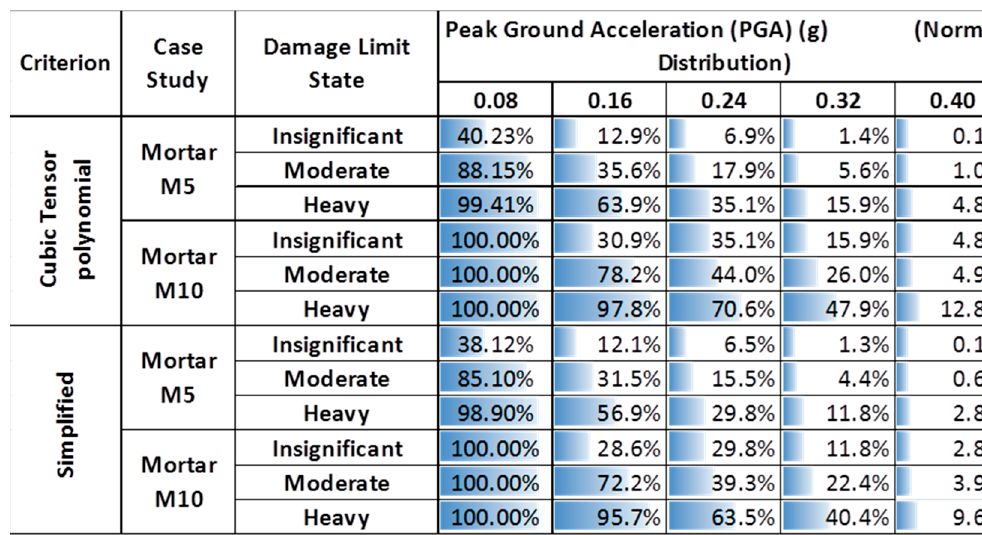
Figure 14. Fragility curves of the existing structure using both failure criteria: ( a ) fragility curves of the existing structure; ( b ) fragility curves of the repaired structure with mortar M5; ( c ) fragility curves of the repaired structure with mortar M10.